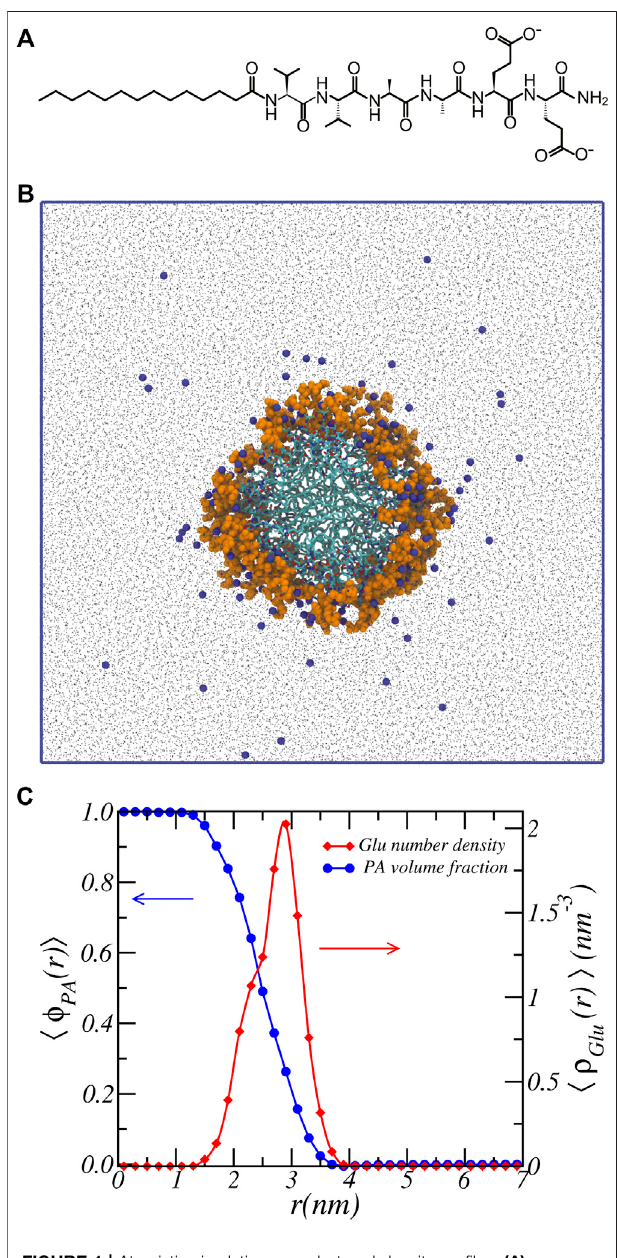
FIGURE 1 | Atomistic simulation snapshot and density pro fi les. (A) chemical structure of C 16 − V 2 A 2 E 2 . (B) Snapshot of the last simulation con fi guration. C 16 − V 2 A 2 E 2 nano fi ber is highlighted at the center, with glutamic acidresidue coloredin orange and hydrogen atomsomitted for display. Na + ions are represented by blue beads, and water by black dots. Blue solid lines denote the simulation box. Aggregation number is 17.3 ± 0.1 PA / nm . (C) VolumefractionofPA- fi berandnumberdensityofGluunitsas a function of radial cylindrical